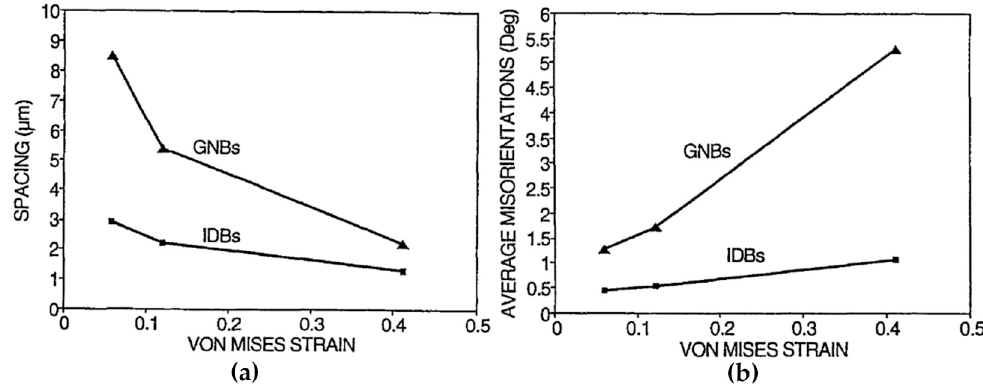
Figure 8. The variations of ( a ) boundary spacing and ( b ) misorientation angle of IDBs and GNBs in dependence of strain in cold-rolled pure Al, respectively. (Reprinted from Reference [79], with permission from Elsevier).